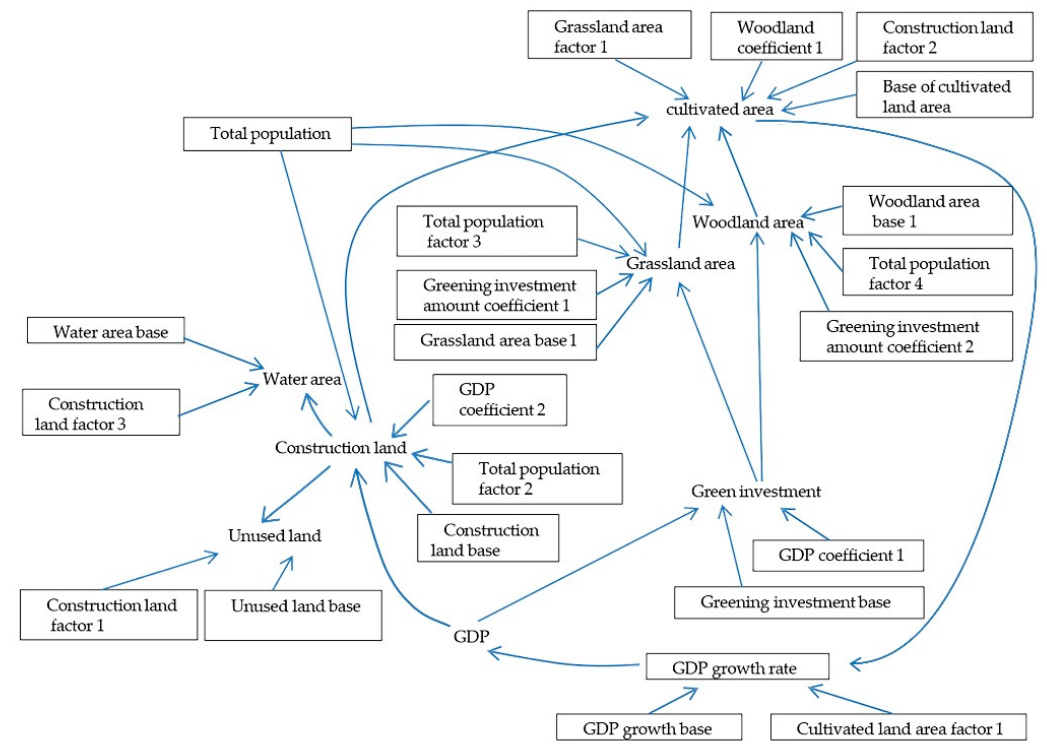
Figure 3. The SD Model’s Causal Feedback Chart Depicting the Composite System of Green Space in Beijing’s Central District. Note: Construction land was delineated into the following urban and rural land-use categories: industrial, mining, and residential land.